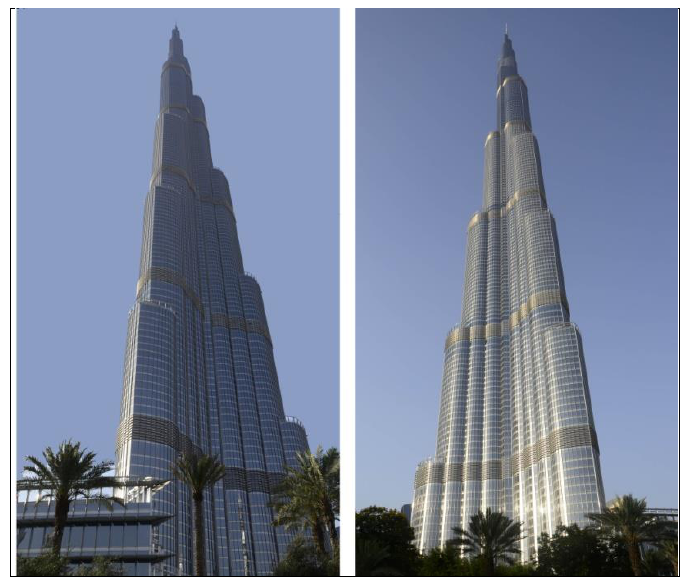
Figure 12. Burj Khalifa (photograph by authors).